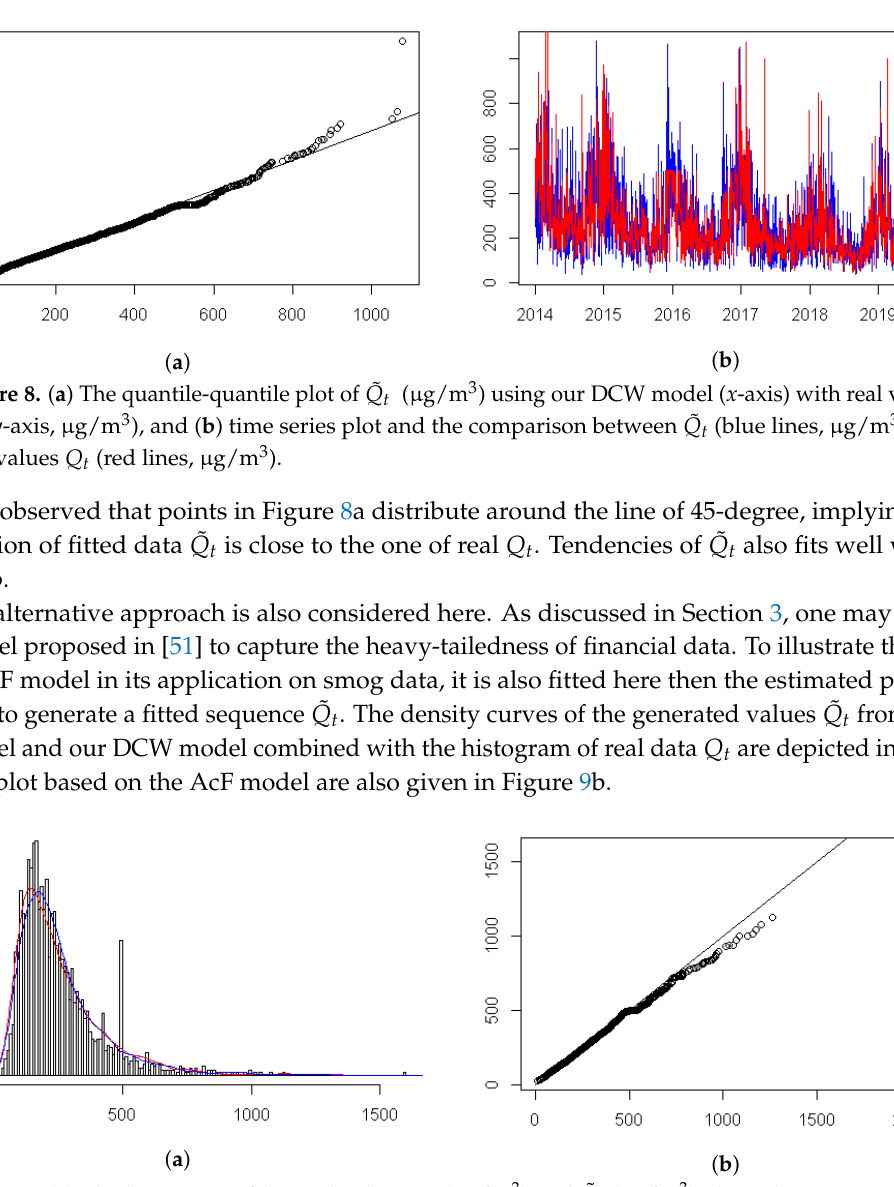
Figure 9. ( a ) The histogram of the real values Q t ( µ g/m 3 ) and ˜ Q t ( µ g/m 3 ); the red curve represents the density curve of fitted values from the DCW model, and the blue one comes from AcF model; and ( b ) is the QQ-plot of Q t ( y -axis, µ g/m 3 ), and the ˜ Q t ( µ g/m 3 ) from AcF model ( x